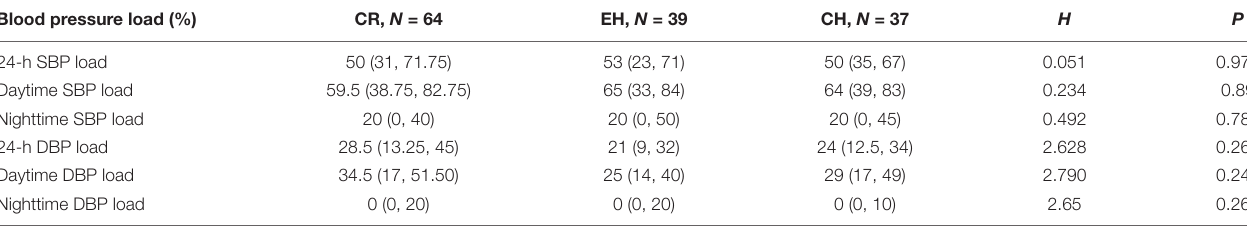
TABLE 4 | The association of blood pressure load with cardiac